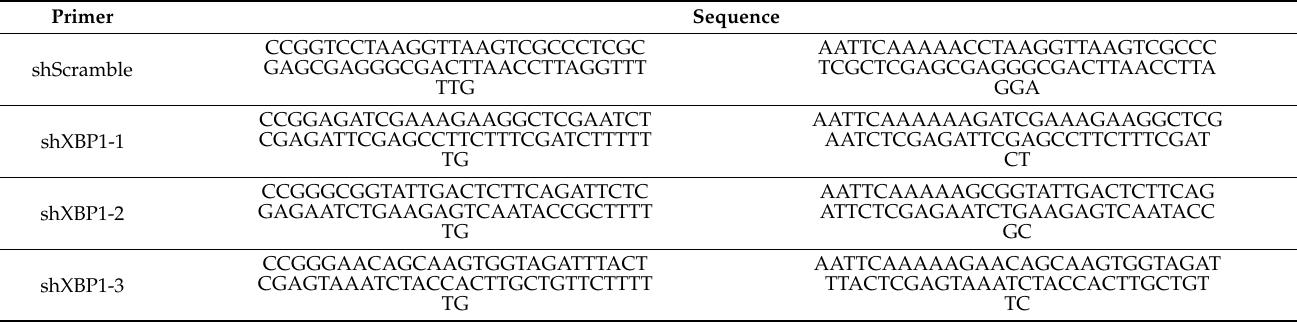
Table 3. Primer information for shRNA of XBP1.